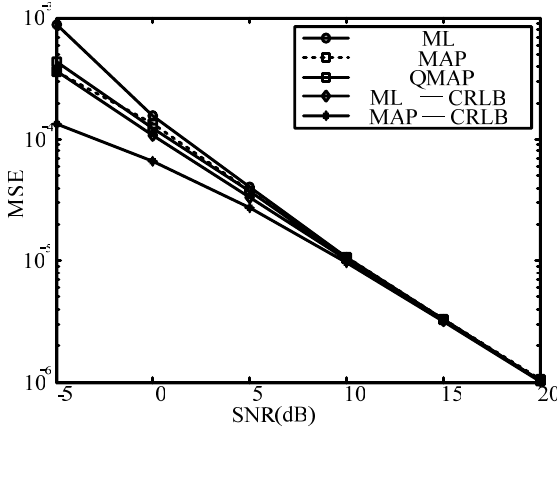
Fig.7.Performance comparison between optimum